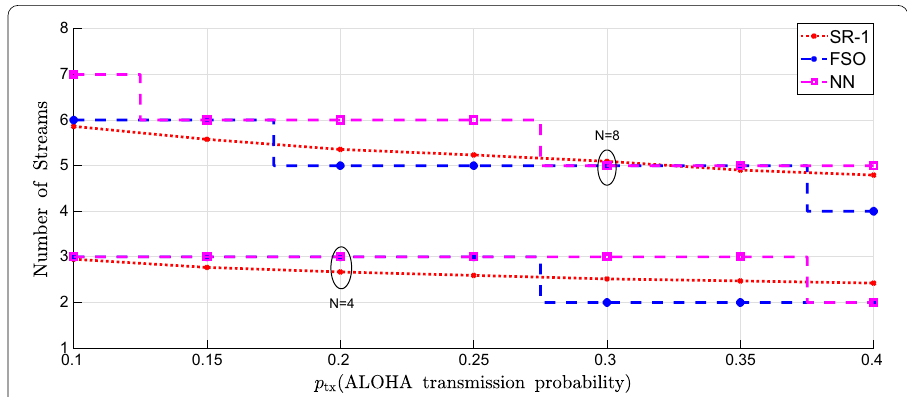
Fig. 5 Selected number of streams vs. ALOHA transmission probability for various routing schemes, where N = { 4,8 } , π r 2 RZ = 10 and α =